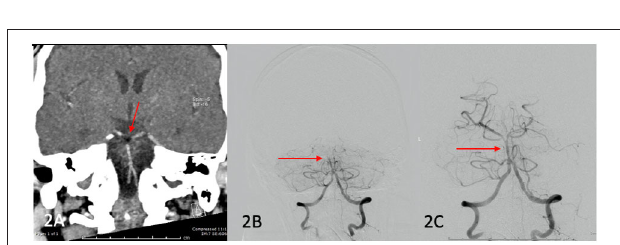
FIGURE 2 | (A) (Red arrow) fat embolism demonstrated in the basilar artery, (B) pre recanalization ECR images confirming occlusive thrombus in basilar artery (red arrow), (C) post recanalization images showing reperfusion of mid and distal basilar artery (red arrow).